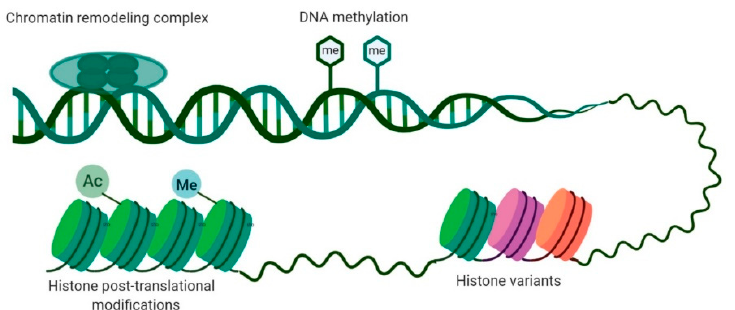
Figure 1. Main epigenetic mechanisms involved in gene expression regulation. DNA methylation consists of the addition of a methyl group in cytosine present in a cytosine–phosphate–guanine (CpG) dinucleotide. Histone post-translational modifications comprise alterations in histone tails such as methylation, acetylation, phosphorylation, and ubiquitination. Histone variants di ff er in few amino acids from canonical histones and regulate chromatin remodeling and histone post-translational modifications. Chromatin-remodeling complexes regulate the nucleosome structure by removing, relocating, and shifting